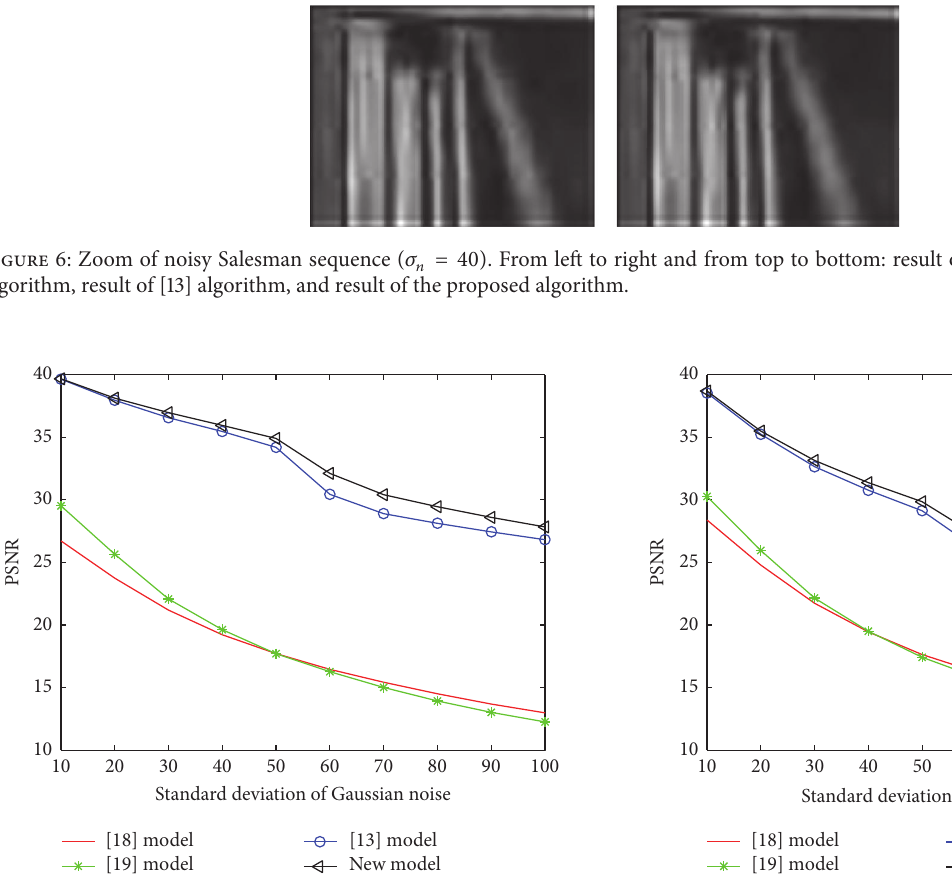
Figure 7: PSNR (dB) graph of [13, 18, 19] and new algorithms for various Gaussian noise for Miss America video sequence.